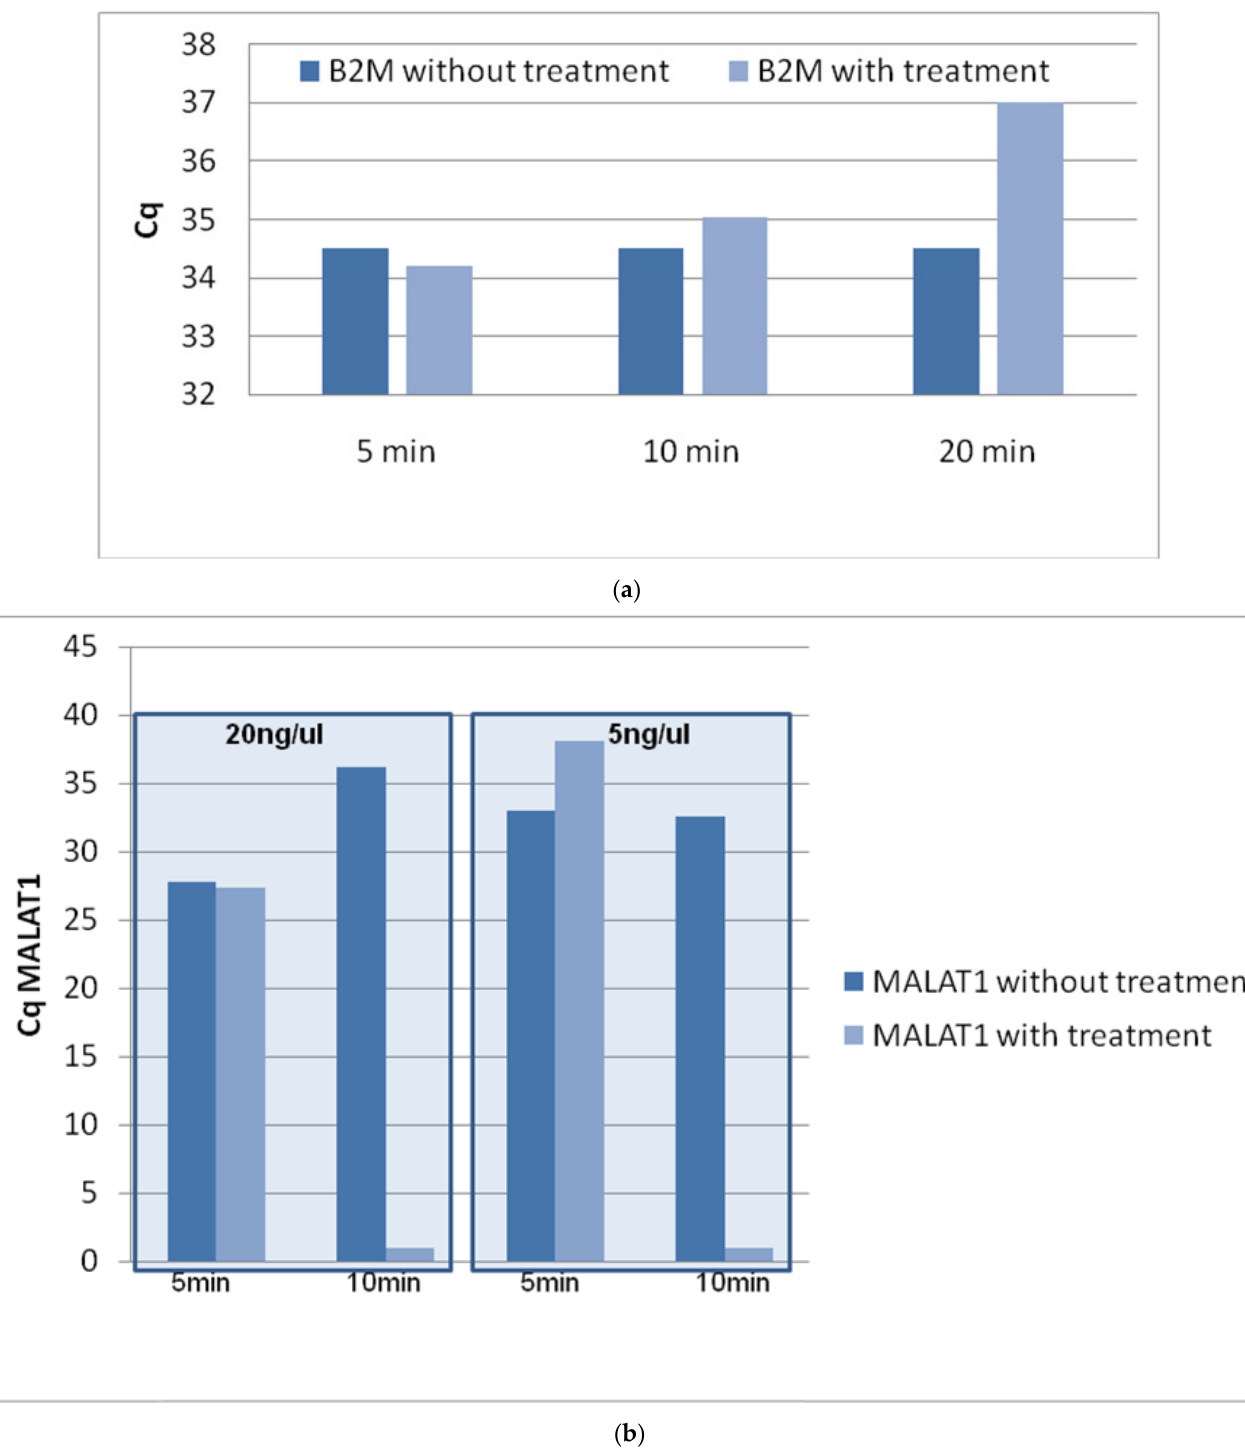
Figure 4. ( a ): Effect of enzyme incubation time. ( b ):Effect of gDNA concentration.